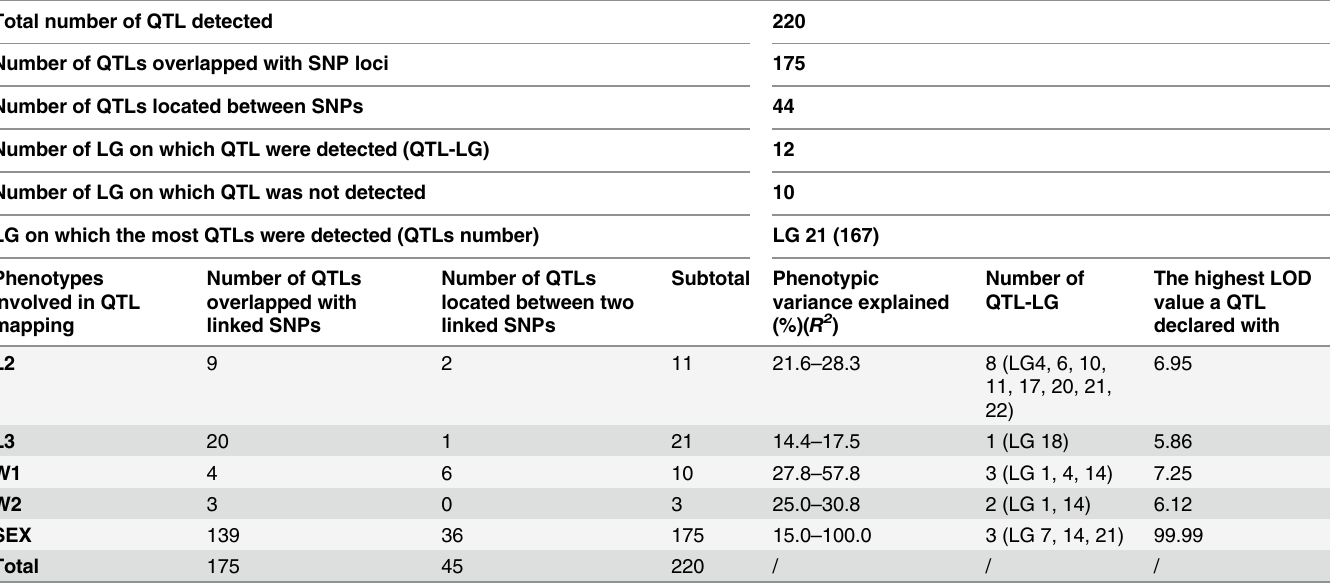
Table 6. Summary of QTLs detected in high-density turbot ( S . maximus ) linkage